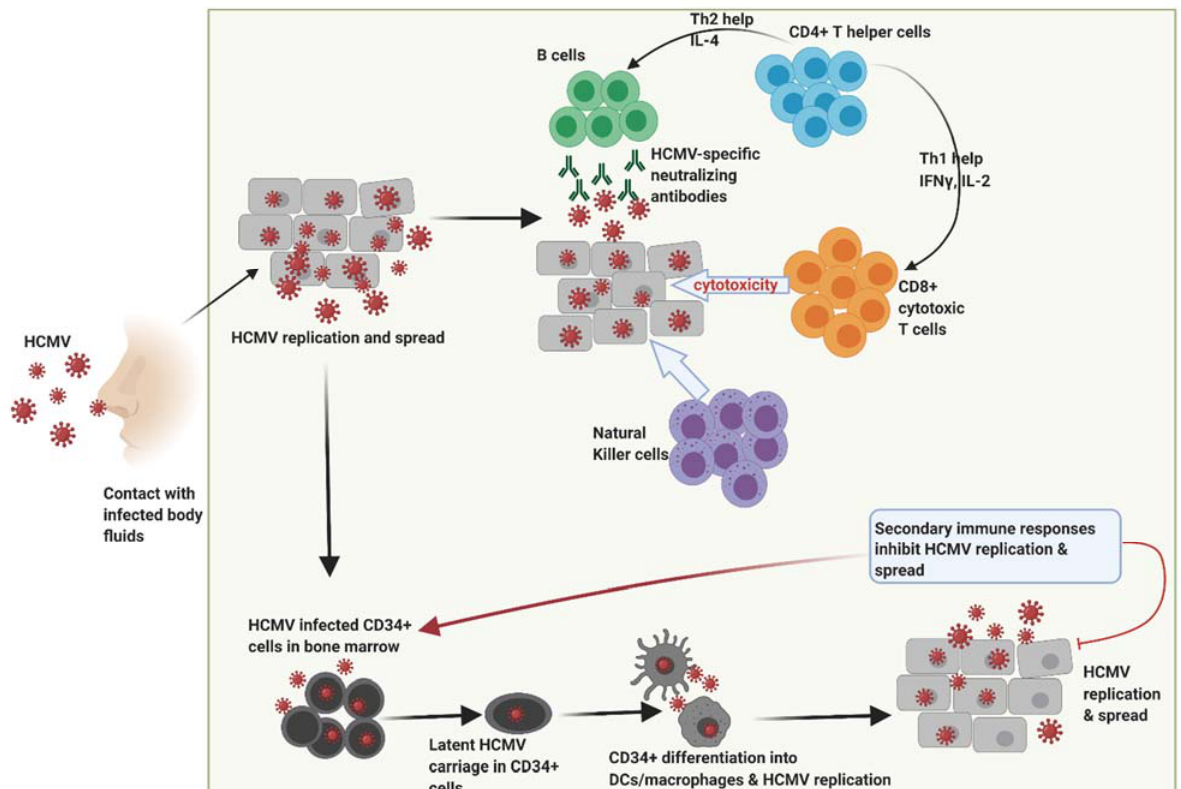
Figure 1. Following primary infection through contact with infected bodily fluids, HCMV replicates within host cells during which time robust immune responses are generated by the host that includes HCMV-specific neutralizing antibodies, natural killer cells and high frequencies of CD4 + T helper cells and CD8 + cytotoxic T cells. These responses subsequently control viral replication thereby resolving primary infection. However, HCMV has the potential to replicate and spread resulting in infection of CD34+ myeloid cells in the bone marrow and establishment of latency. Differentiation of HCMV-infected CD34+ cells into dendritic cells and macrophages contributes to new HCMV replication during which a secondary immune response induced that helps to inhibit HCMV replication spread. HCMV, human cytomegalovirus. Figure created with BioRender.com.